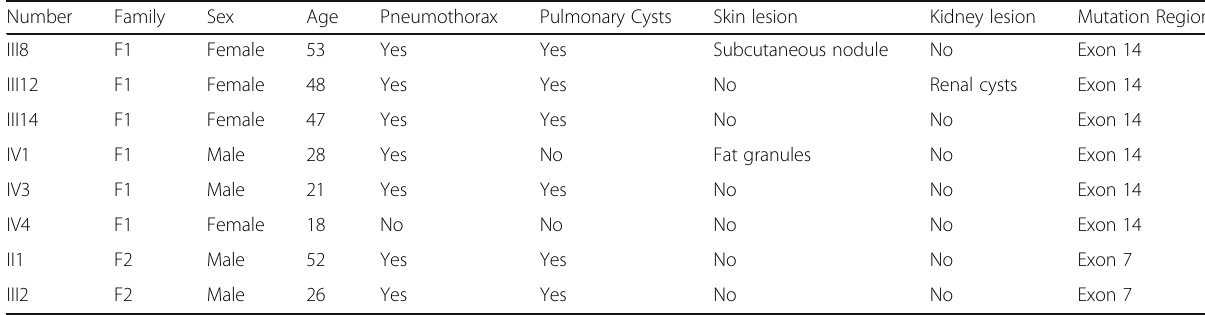
Table 2 Summary of clinical information of the two families